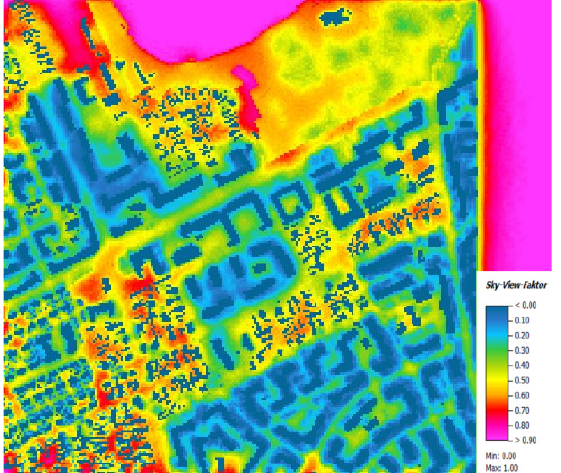
Figure 2. The simulated Sky View Factor pointing out areas with the sky almost not visible.